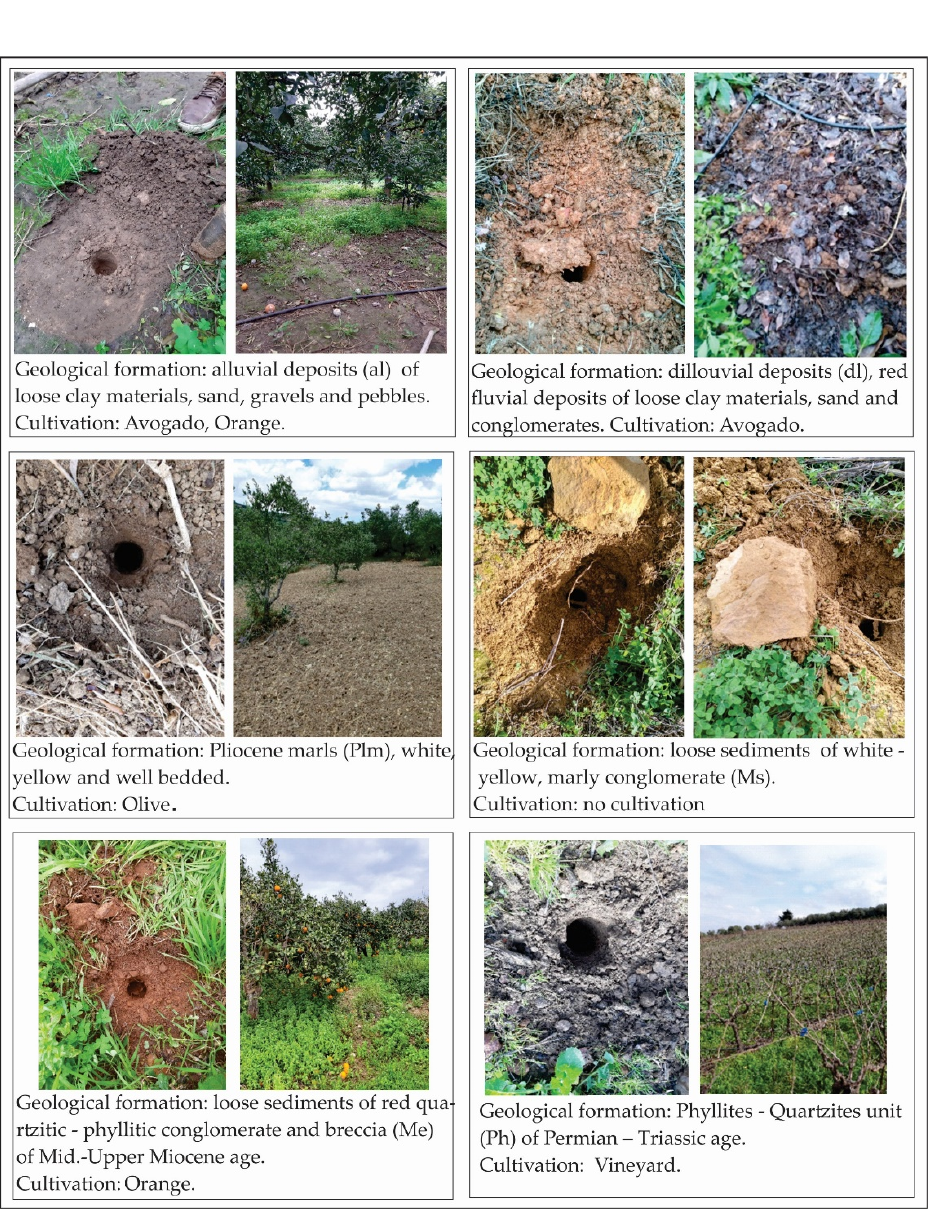
Figure A2. Geological formations in the arable fields of the study area. Photos are from the sam- pling campaign.